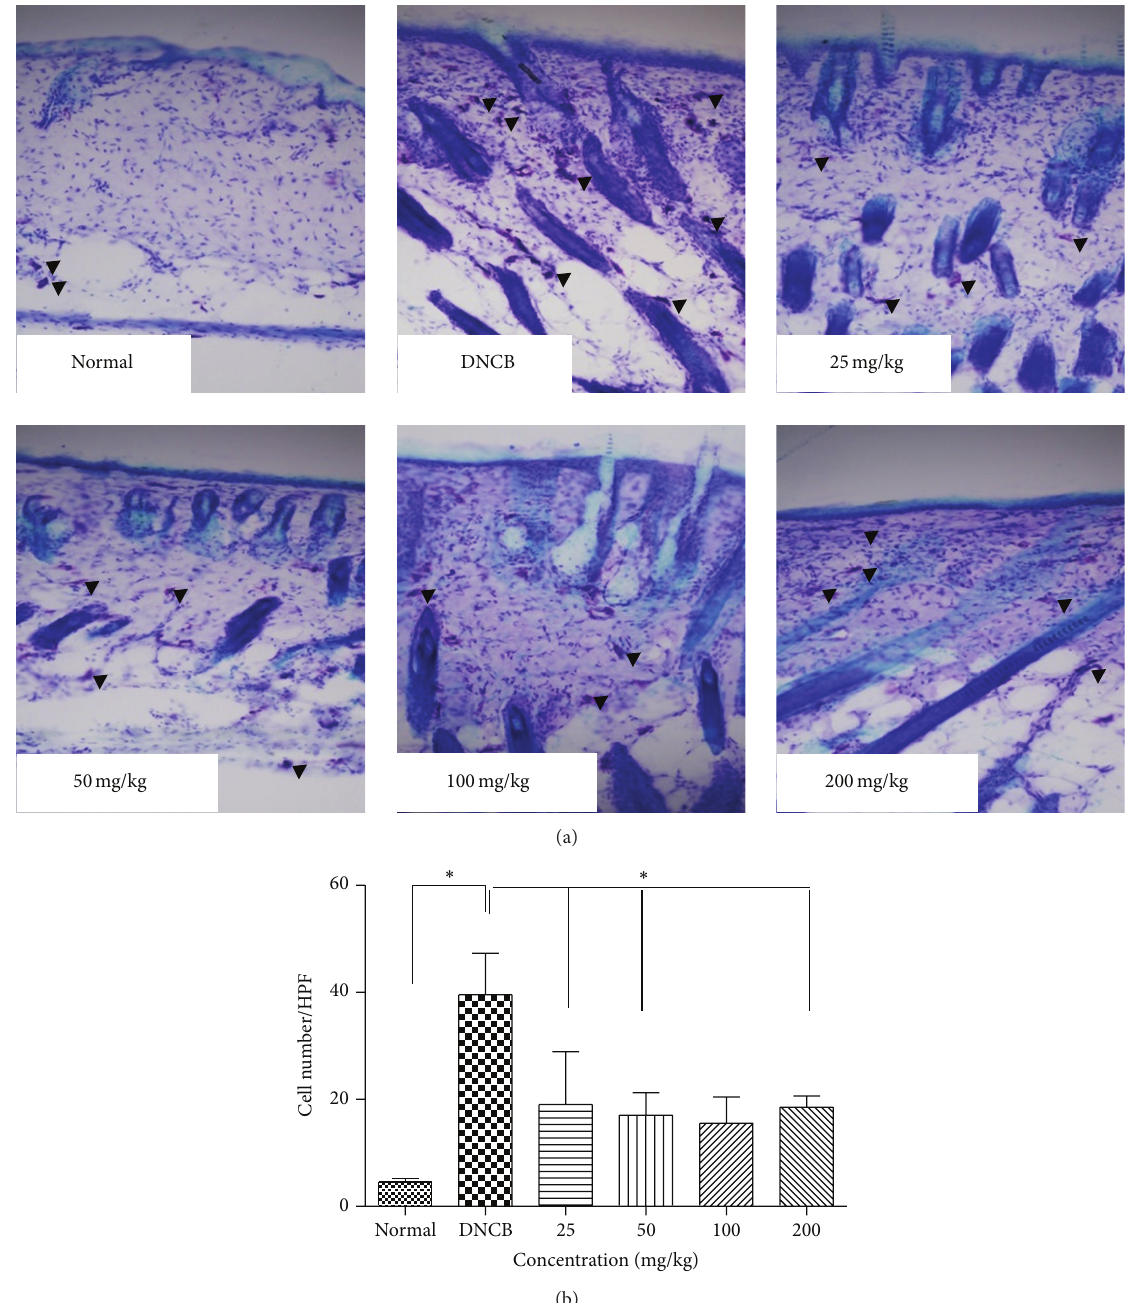
Figure 3: The measurement of mast cells number in AD-like skin lesions treated with CP001. The skin sections were stained with toluidine blue for mast cells staining. Sections were evaluated using microscope at an original magnification of 400x. The data are presented as mean ± SD from five animals in each group. ∗ 𝑃 < 0.05